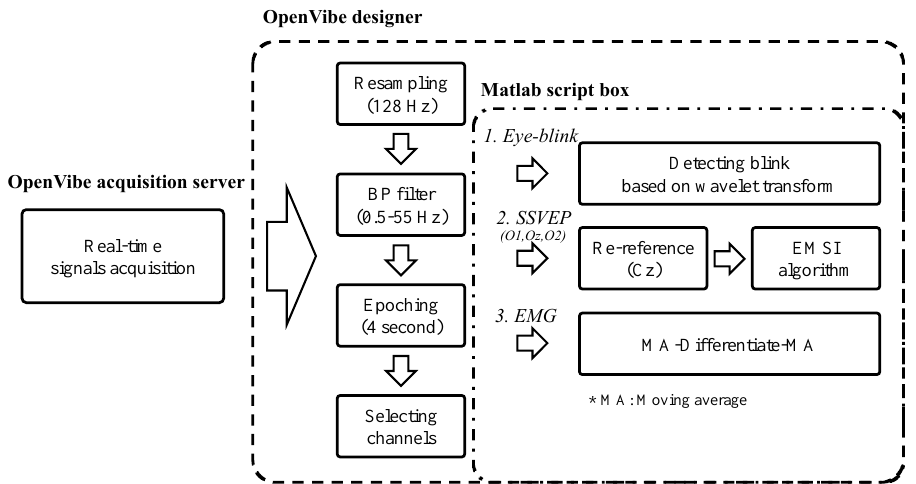
Figure 5. Procedure of EEG acquisition and processing in real-time system. Elliptic infinite impulse response filter band-